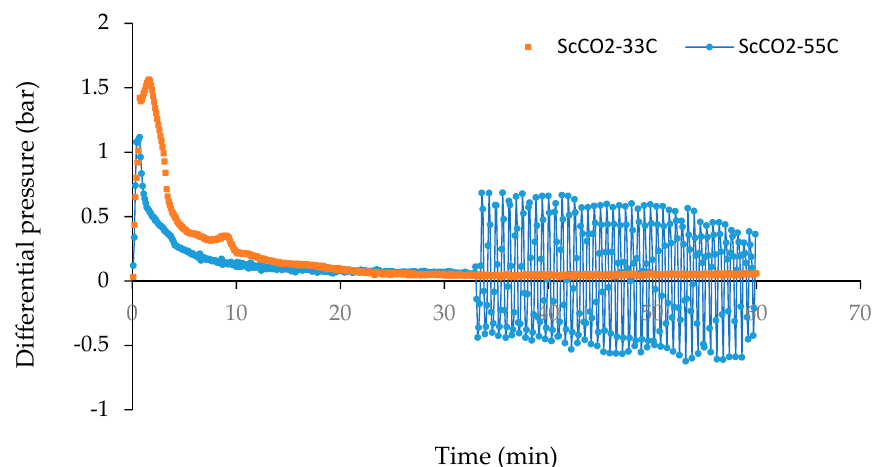
Figure 12. Effect of experimental temperature on the differential pressure profile of ScCO 2 –oil displacements conducted at 0.4 mL/min and 90 bar.